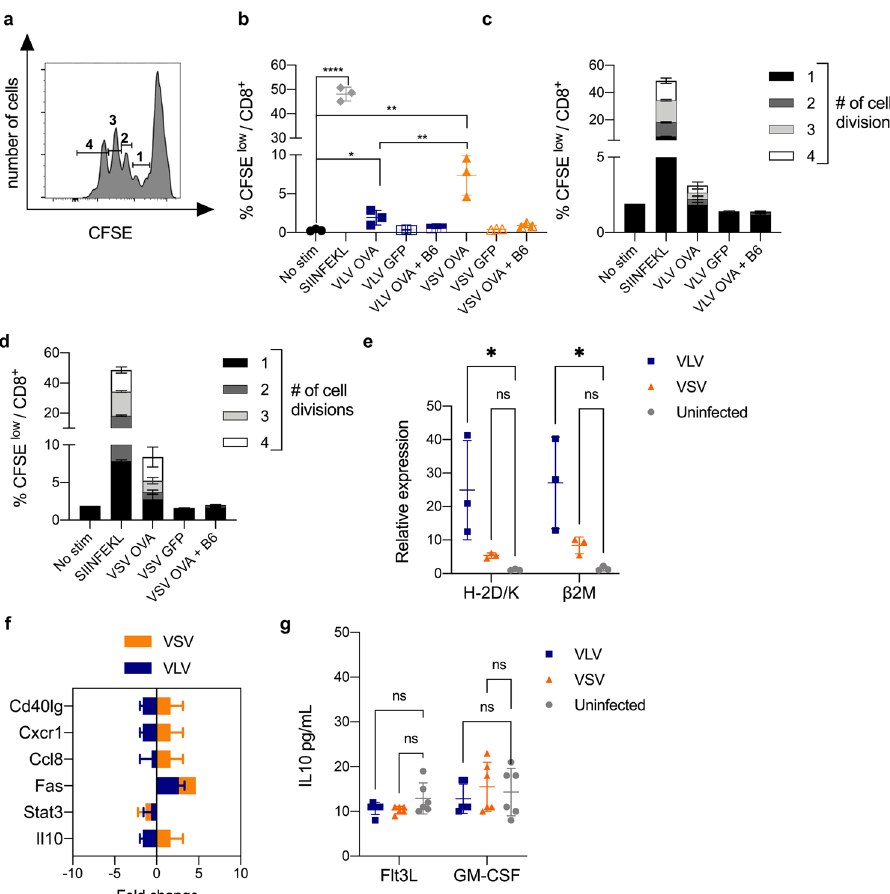
Fig. 3 VLV- and VSV-infected BMDCs activate antigen-speci fi c CD8 + T cells in vitro. a Flt3L-derived BMDCs were infected with VLV or VSV expressing OVA (MOI 10) for 18 h. A positive control consisted of incubating DCs with SIINFEKL peptide for 18 h. After infection or SIINFEKL incubation, cells were washed and co-cultured with CFSE-labeled OT-I splenocytes for 72 h (Ratio = 1:30). b Proliferation of SIINFEKL-speci fi c cells was measured by loss of CFSE fl uorescence intensity by fl ow cytometry. Percentage of b total proliferation (CFSE low in CD8 + cells) and the number of cell divisions in co-cultures of OT-I cells with c VLV or d VSV-infected DCs. e H-2K/D and B2M RNA levels were measured by RT- qPCR normalized to GAPDH. f RT 2 PCR RNA analysis of IL-10 and other unchanged genes associated with antigen presentation in Flt3L DCs 6 h post-infection relative to uninfected control. g IL-10 production by DCs 18 hpi with VLV, VSV, or uninfected control was measured by ELISA. Data are expressed as mean ± standard deviation. * p < 0.05, ** p < 0.01, **** p < 0.0001 compared to uninfected control by unpaired t -test, one- or two-way ANOVA. The VLV and VSV infections were performed concurrently in the same